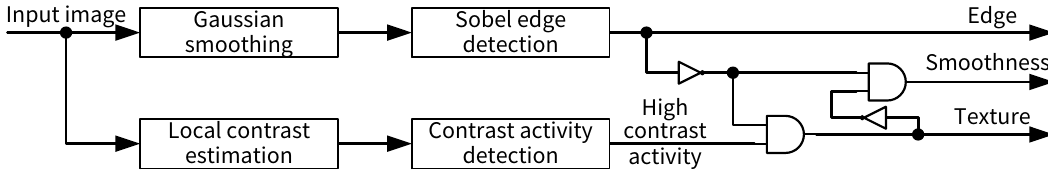
Figure 5. Edge, texture and smooth region detection scheme.